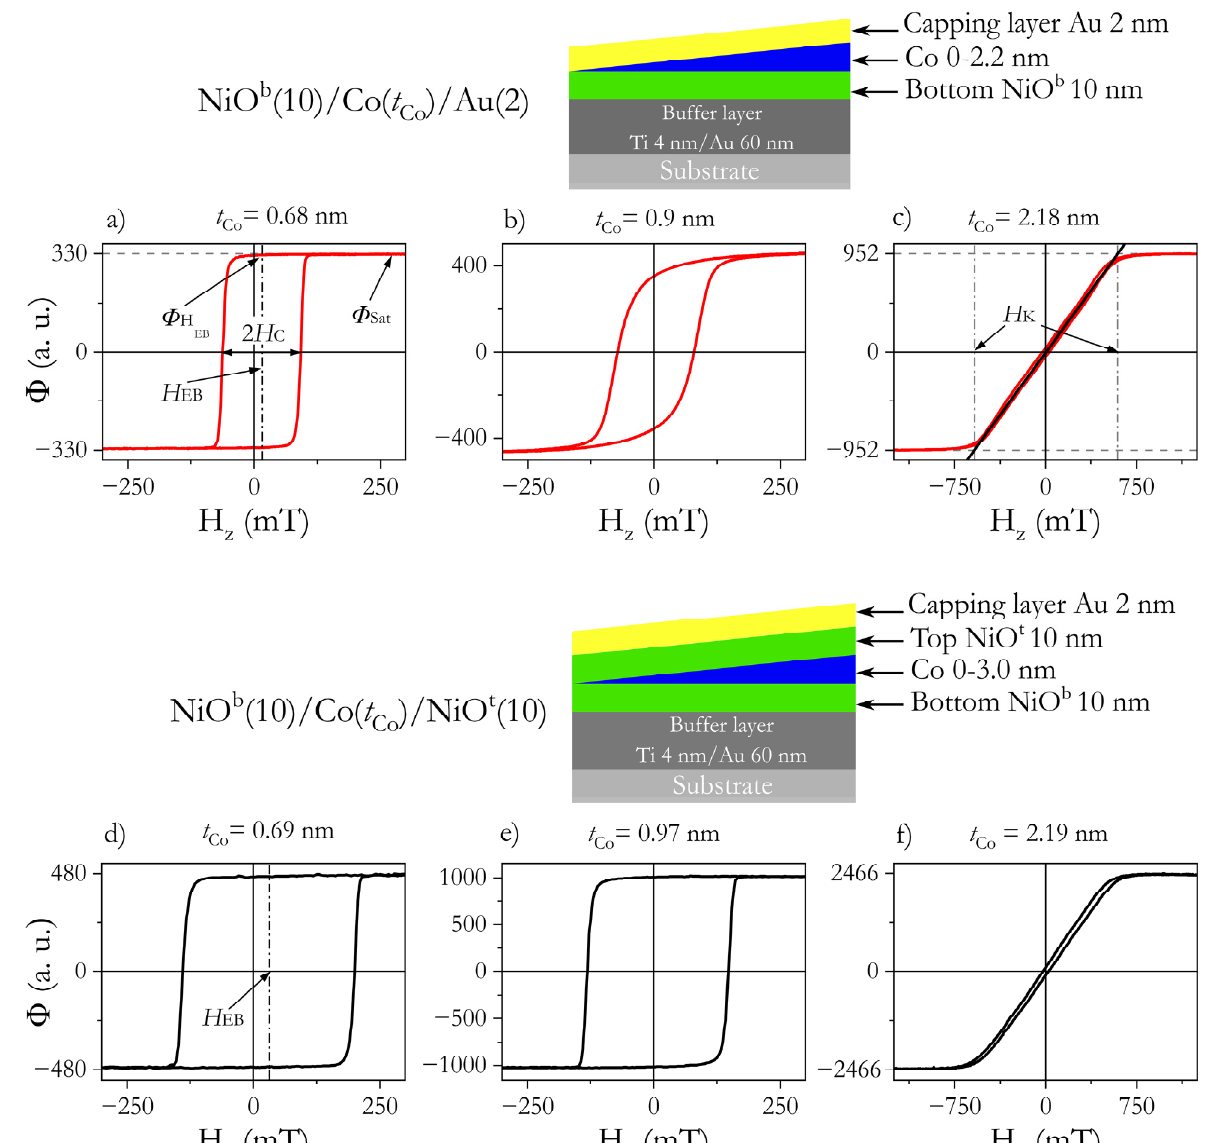
Figure 1. Morphology of samples and representative PMOKE hysteresis loops for the NiO b /Co-wedge/Au system: ( a ) t Co = 0.68 nm, ( b ) t Co = 0.9 nm, ( c ) t Co = 2.18 nm and for the NiO b /Co-wedge/NiO t system: ( d ) t Co = 0.69 nm, ( e ) t Co = 0.97 nm, ( f ) t Co = 2.19 nm.